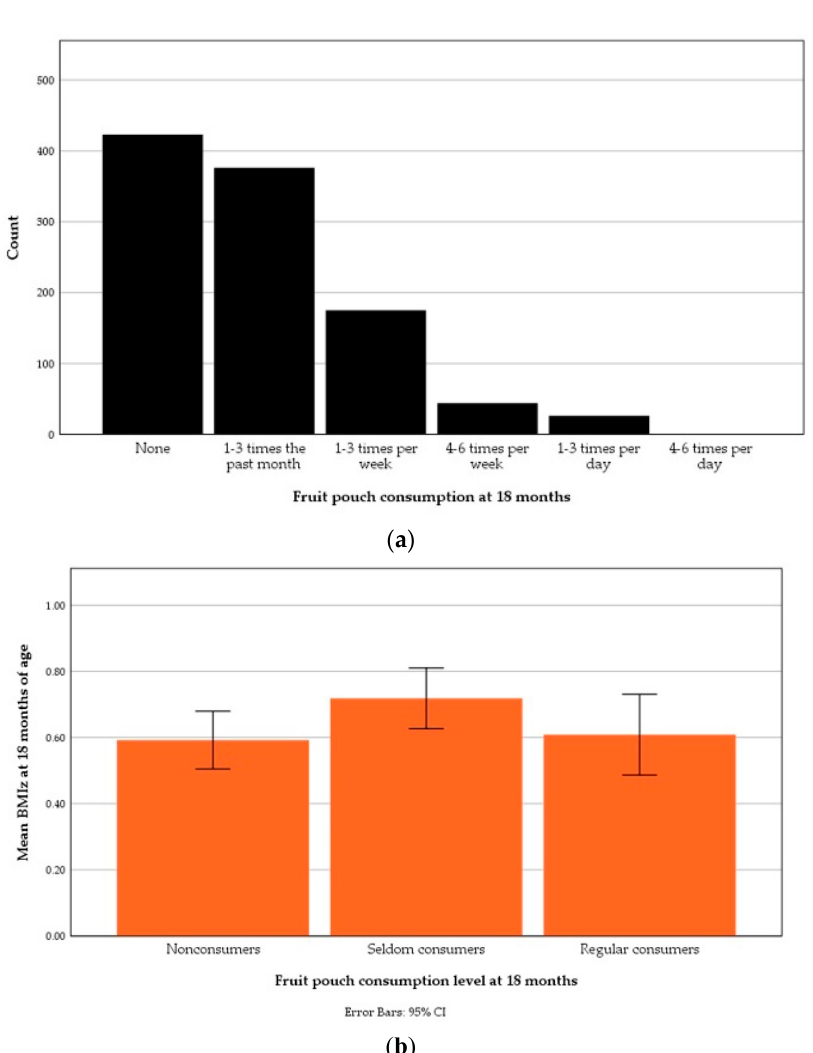
Figure 2. Fruit pouch consumption during the past month at 18 months of age: ( a ) Distribution according to one-month-recall food frequency questionnaire responses; ( b ) An error bar graph illustrating mean body-mass index z -score (BMIz) at 18 months of age according to consumption level.